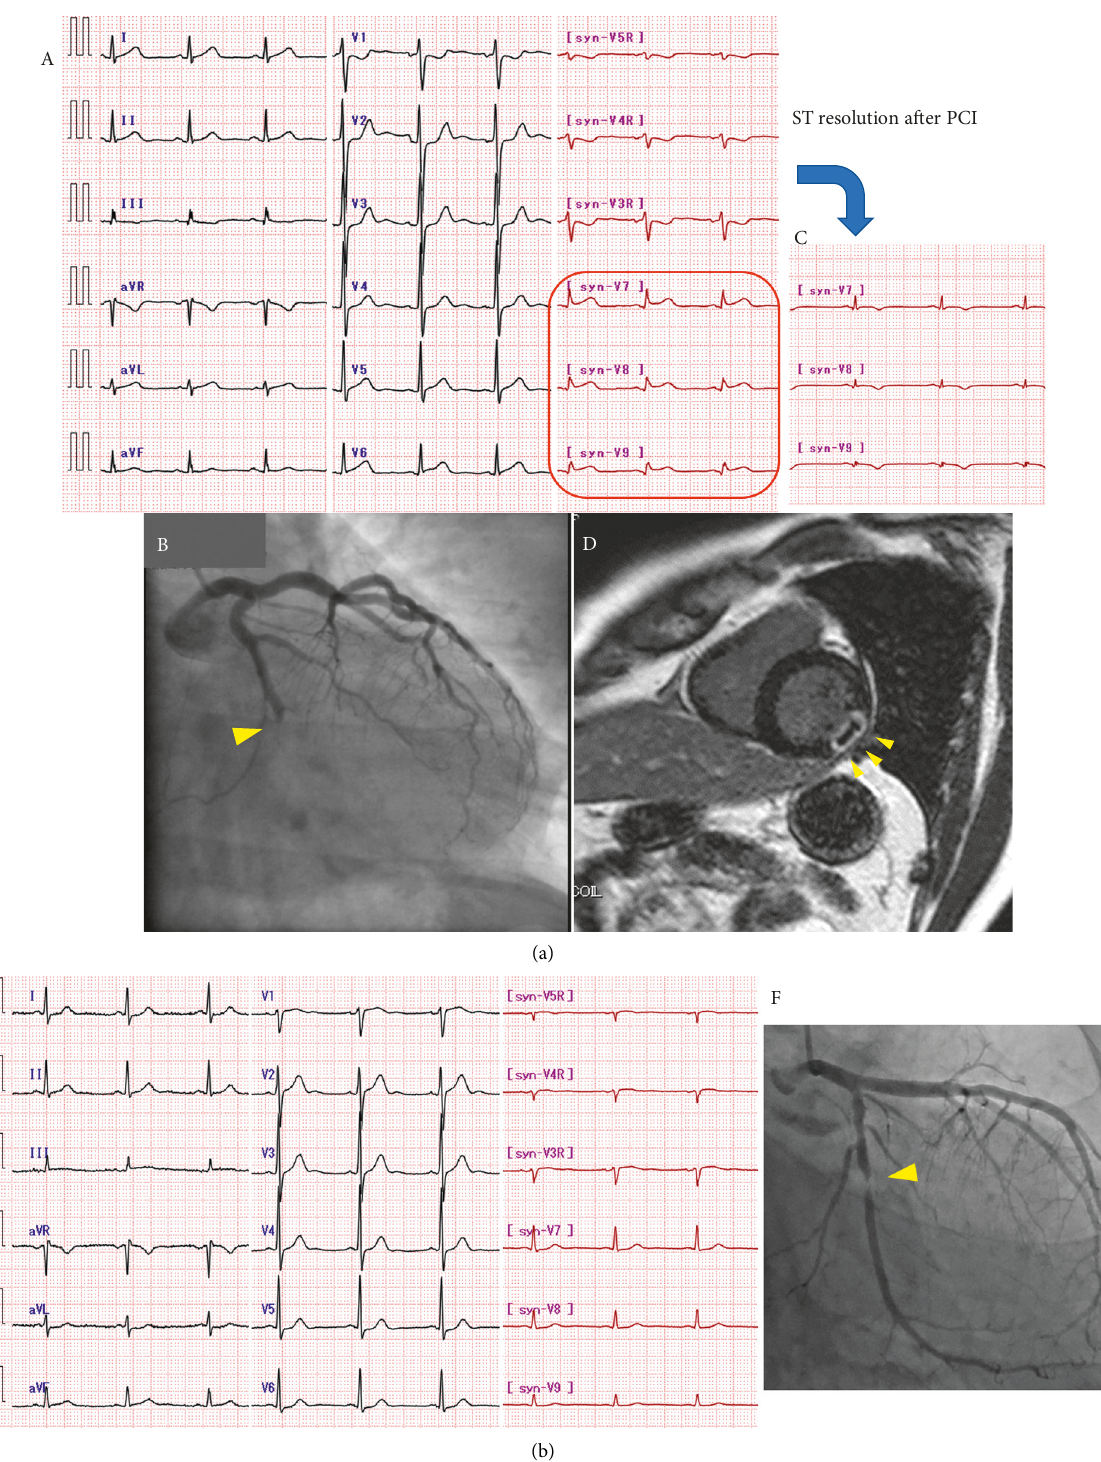
Figure 3: Representative cases. (a) The case is a 44-year-old man. On admission, synthesized V7-9 ST-segment elevation (STE) is observed, accompanied by ST-segment depression in V1 and V2 (A). Urgent coronary angiography confirmed thrombolysis in myocardial infarction (TIMI) 0 flow of the mid left circumflex (LCx) culprit (B). After successful revascularization, ST-segment resolution in synthesized V7-9 (C), and late gadolinium enhancement of the posterior wall (D) were observed. (b) The case is a 42-year-old man. On admission, the elec- trocardiogram including synthesized V7-9 was nondiagnostic (E). Urgent CAG revealed 90% stenosis with TIMI 3 grade flow of the mid LCx